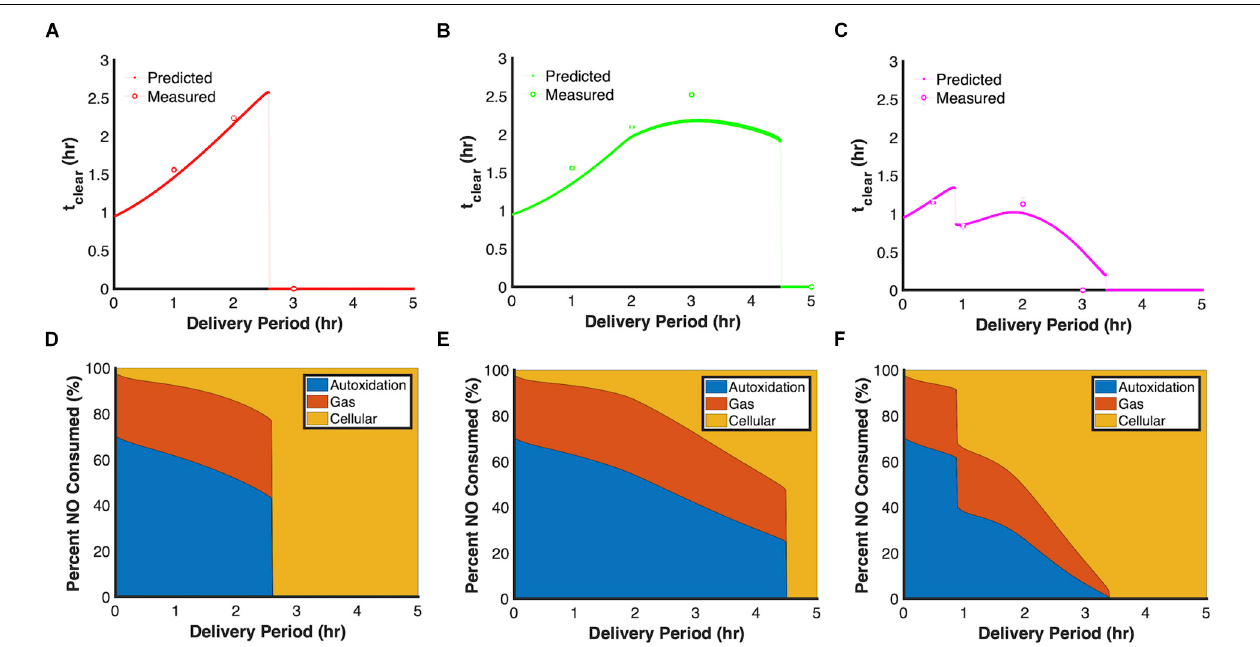
FIGURE 5 | Relationship between t clear and delivery period. Model simulations using the ensemble of parameter sets (ER < 10, 28 sets in total) were performed by delivering 24 µ mol PAPA NONOate and varying the delivery period between 0 and 5 h and calculating t clear for each simulation. (A) Constant, (B) ramp down, (C) ramp up. Solid lines represent predicted relationship between t clear and delivery period, while dashed lines represent discontinuities in the curves. Circles represent mean t clear values from at least three experiments and error bars represent the standard error of the mean. Predicted NO cumulative distribution profiles using the optimal parameter set (ER = 1, minimum SSR, 1 set) up to the end of the delivery period or when [NO] dropped below 0.5 µ M, whichever was greater for constant (D) , ramp-down (E), and ramp-up (F) delivery schedules. The three major NO consumption pathways are autoxidation (blue), transport to gas phase (red), and cellular consumption (yellow).